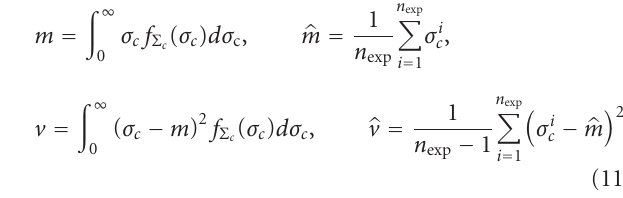
Figure 4: Experimental measurements ( σ i cerebral aneurysms (symbols) and fitted density distribution f Σ (solid